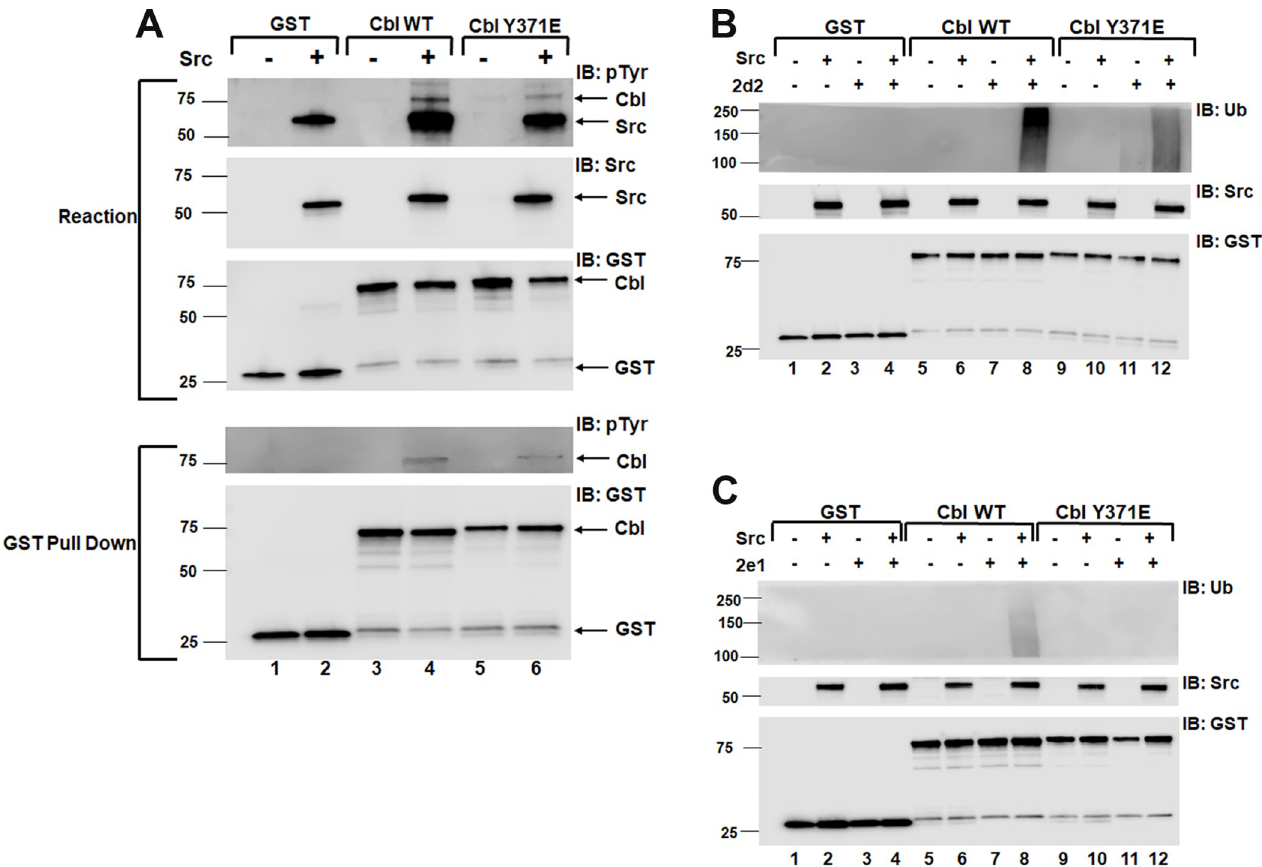
Fig 3. Phosphorylation of wild-type Cbl enhances autoubiquitination to a greater degree than the Y371E phosphomimetic mutation in vitro . (A) GST, wild-type GST-Cbl (Cbl WT) or Y371E mutant GST-Cbl (Cbl Y371E) were incubated in the E3 assay buffer lacking E2 for 60 min at 30˚C. An aliquot of the reaction mixture was immunoblotted for phosphotyrosine (pTyr), Src, and Cbl (using the anti-GST antibody) as indicated. GST-Cbl was precipitated from a second aliquot of the reaction using GSH-agarose and again immunoblotted for phosphotyrosine or Cbl (using the anti-GST antibody). Aliquots of the phosphorylation reaction were tested for E3 activity with or without Ube2d2 (B) or Ube2e1 (C) as described in the methods. The E3 autoubiquitination assays were immunoblotted for ubiquitin (Ub), Src, or Cbl (using the anti-GST antibody) as indicated.